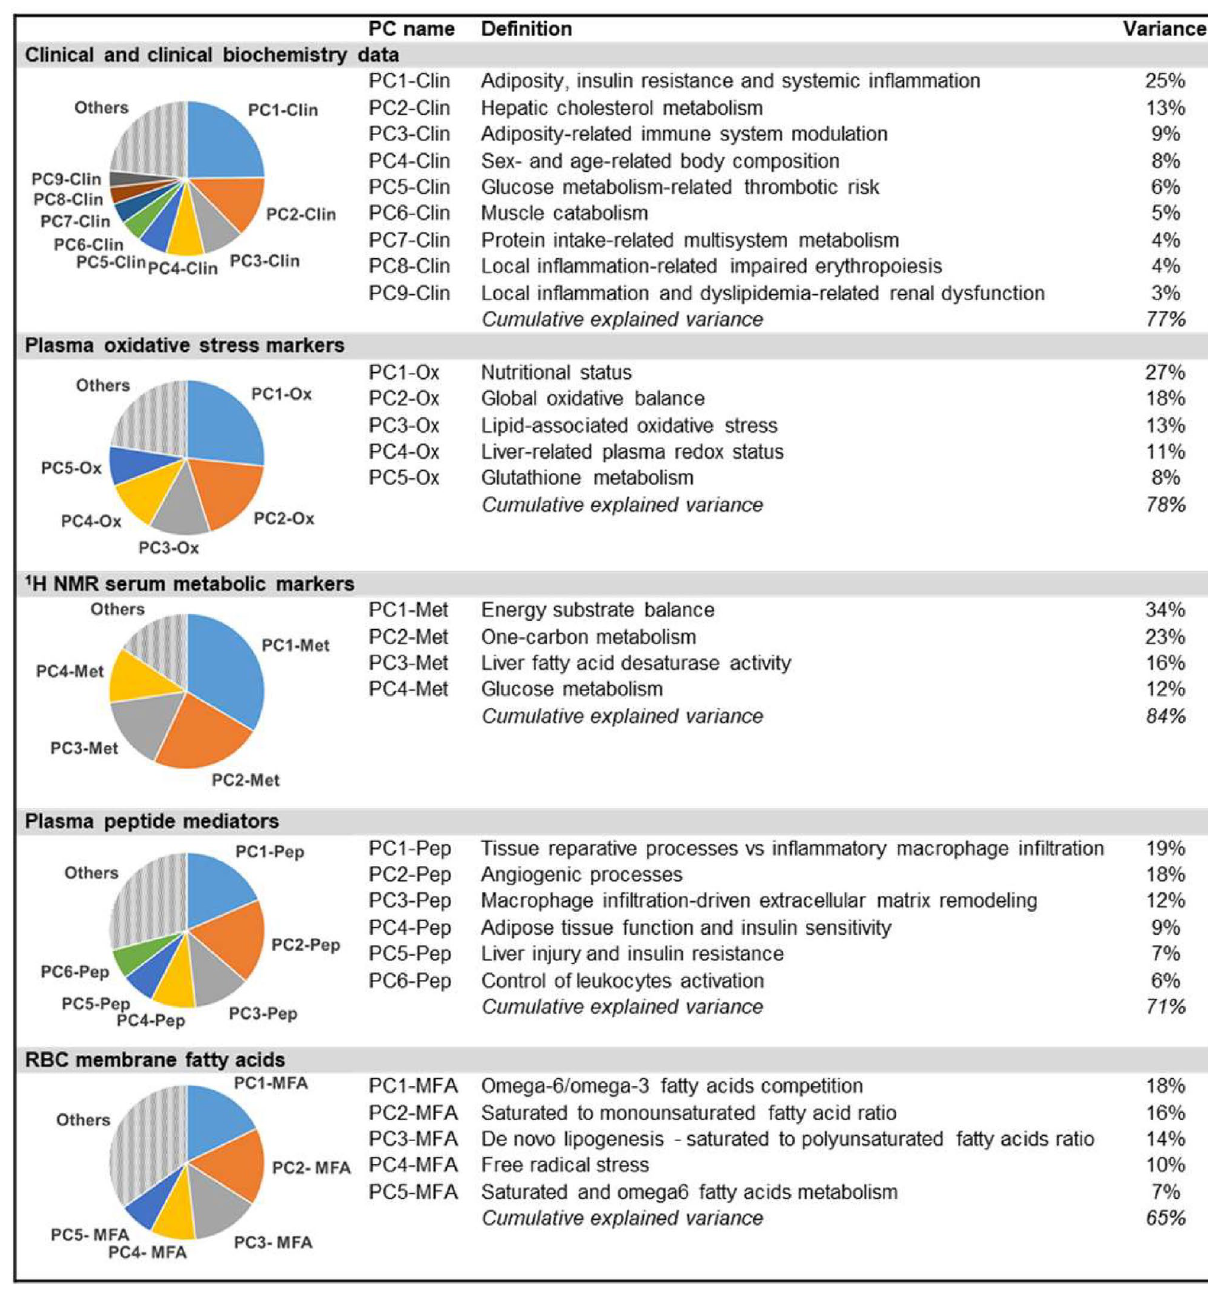
Figure 2. Principal components analysis. The main PCs extracted from each data set are presented in terms of percentage of explained variance and biological significance as inferred by component loading matrix (see Supplemental material for